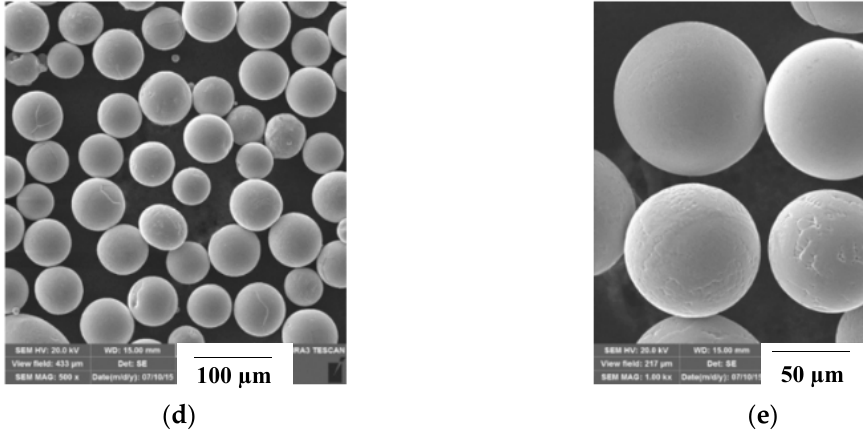
Figure 6. Comparison of metal powder obtained from different production processes. Gas atomized particles [99]: ( a ) SEM image 100 × ; ( b ) SEM image at 500 × ; ( c ) LOM of GA particles in the metallographic section. Plasma atomized particles [100]: ( d ) SEM image at 500 × ; ( e ) SEM image 1000 × ; with permission from John Wiley and Sons, 2019.